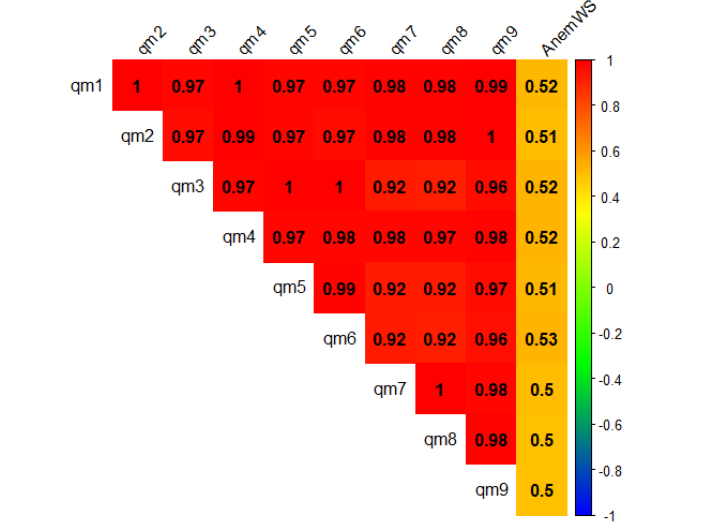
Figure 11. Correlation table of the calibrated wind speed series from each ERA5 grid point and the measured wind speed